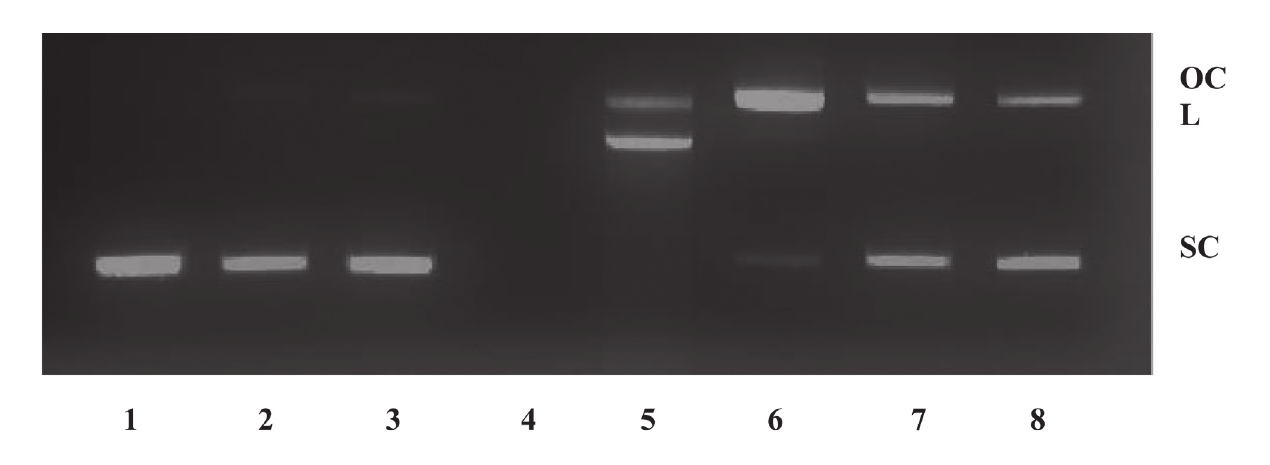
FIGURE 5 – Gel electrophoresis of pUC-19 DNA in the presence of Cu(II) and AA. Saturated air solution ([O